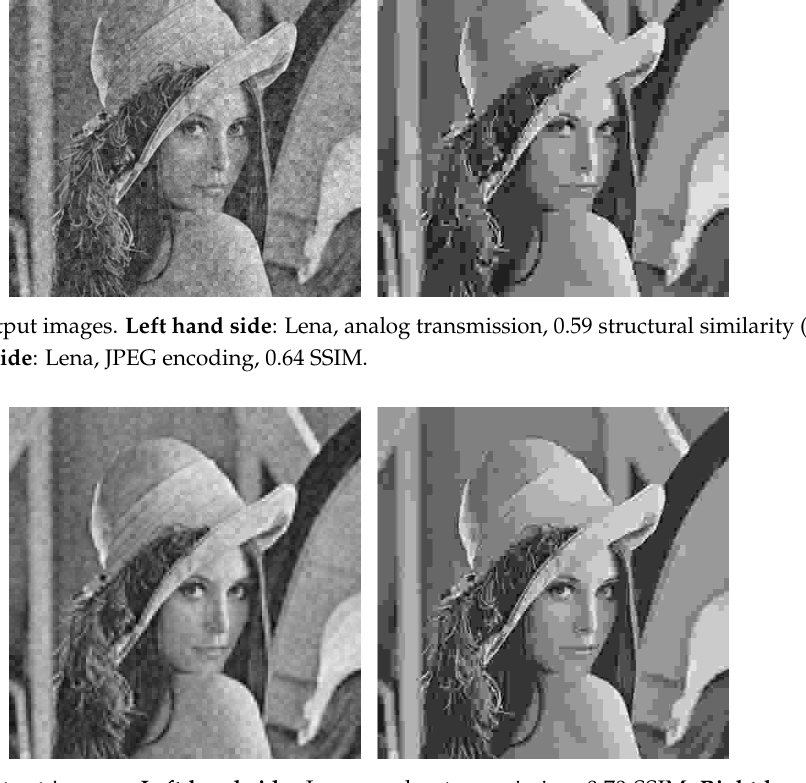
Figure 6. Output images. Left hand side : Lena, analog transmission, 0.70 SSIM. Right hand side : Lena, JPEG encoding, 0.72 SSIM.